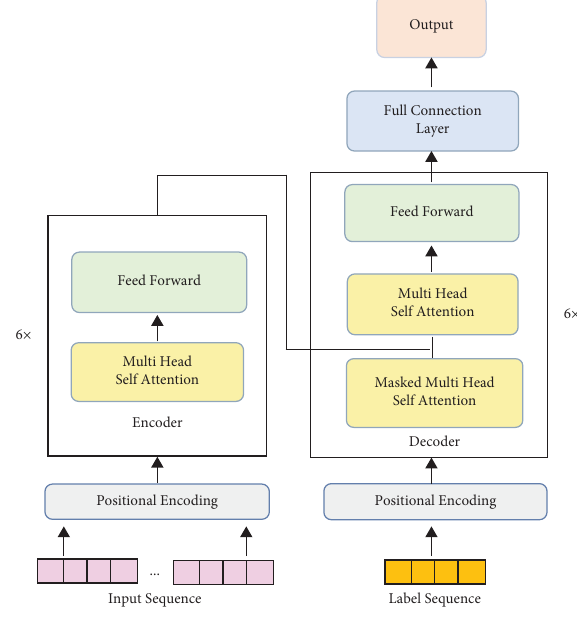
Figure 1: Te model